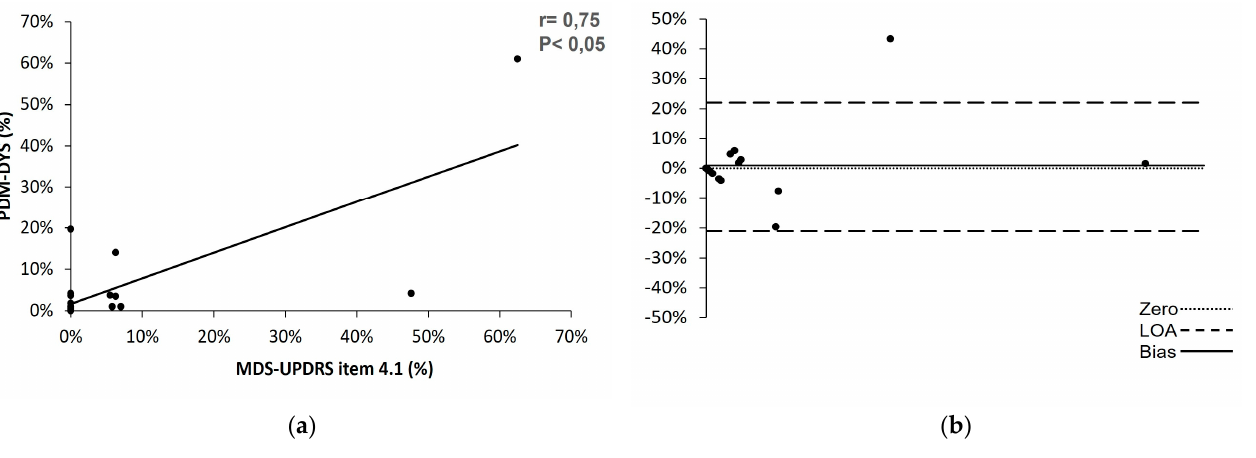
Figure 9. The correlation between the PDMonitor ® and the MDS-UPDRS for dyskinesia using a ( a ) Pearson correlation plot and ( b ) Bland–Altman test. DYS, percent time on dyskinesia as recorded by the PDMonitor ®